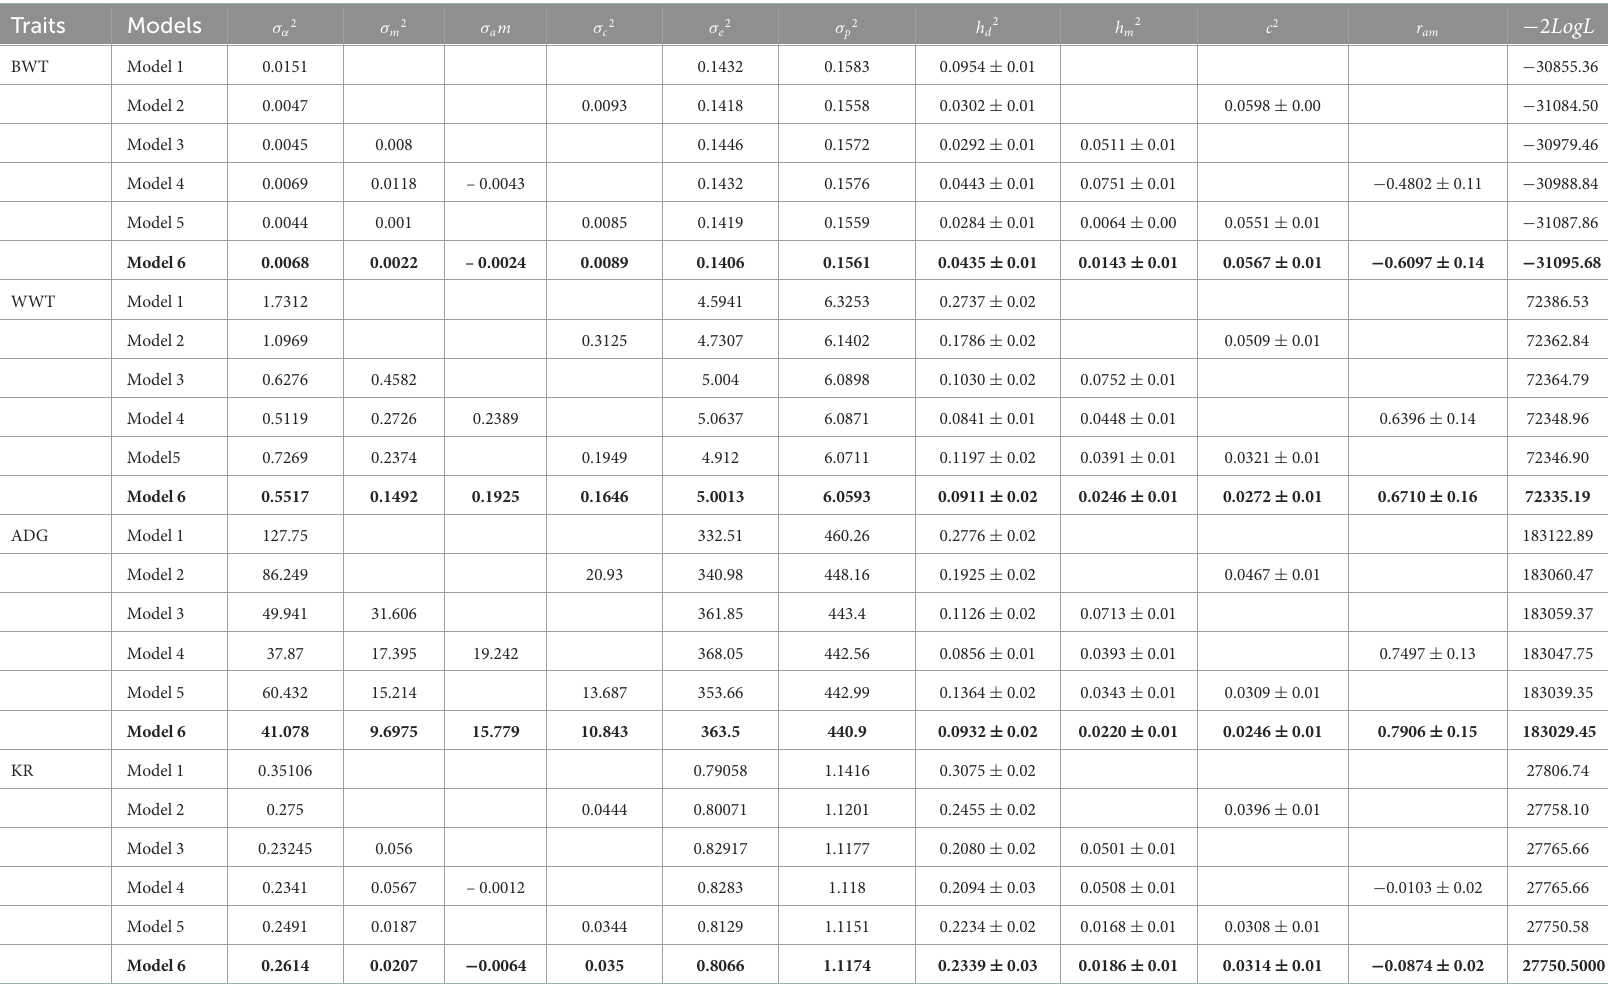
TABLE 4 Estimates of the (co)variance components and the genetic parameters studied for the traits.